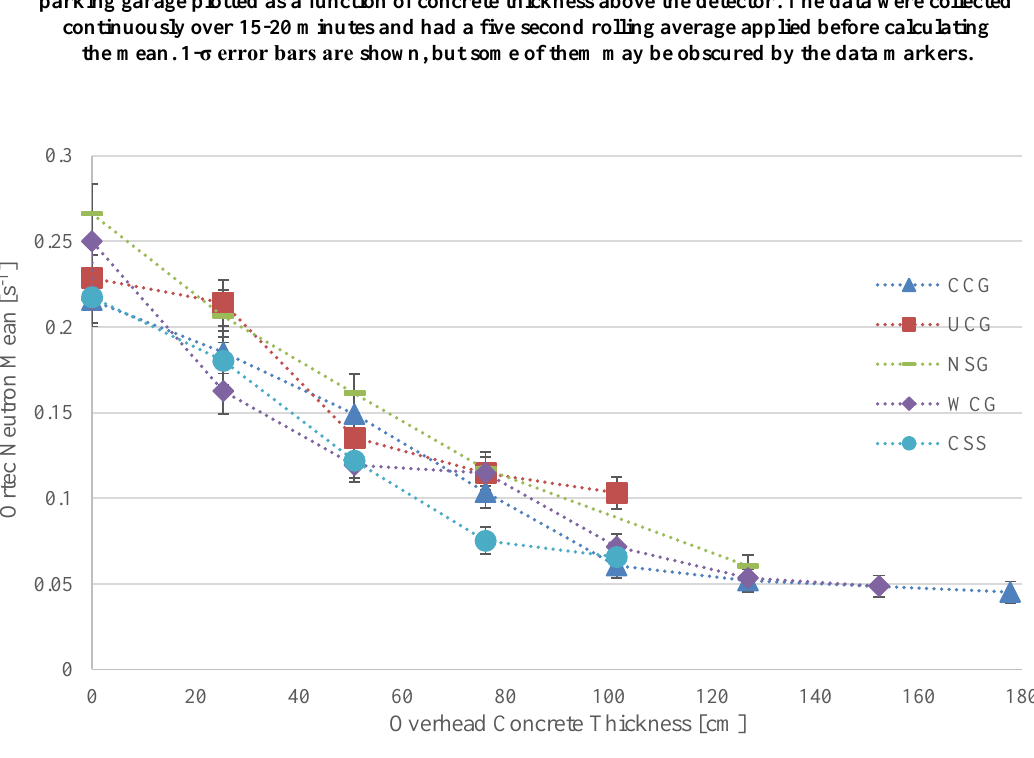
Figure 6. The mean Ortec neutron count rate at each location in each parking garage plotted as a function of concrete thickness above the detector system. The data were collected continuously over 15-20 minutes and had a five second rolling average applied before calculating the mean. 1-σ error bars are shown, but some of them may be obscured by the data